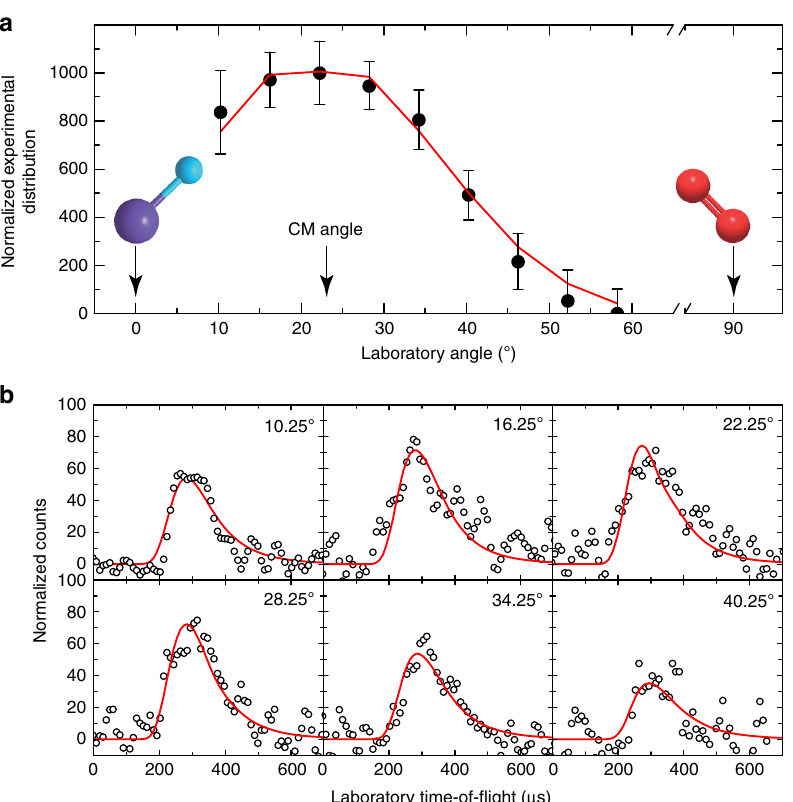
Fig. 1 Laboratory angular distribution and the associated time-of- fl ight spectra. Laboratory angular distribution at mass-to-charge ratio of 60 (SiO 2 + ) recorded in the reaction of the D1-silylidyne radical with molecular oxygen ( a ), and the time-of- fl ight spectra recorded at distinct laboratory angles overlaid with the best fi ts ( b ). The solid circles with their error bars indicate the normalized experimental distribution with ±1 σ uncertainty (s.d. of the integrals of the time-of- fl ight spectra for the respective angle), and the open circles indicate the experimental data points of the time-of- fl ight spectra. The red lines represent the best fi ts obtained from the optimized center-of-mass (CM) functions, as depicted in Fig. 2